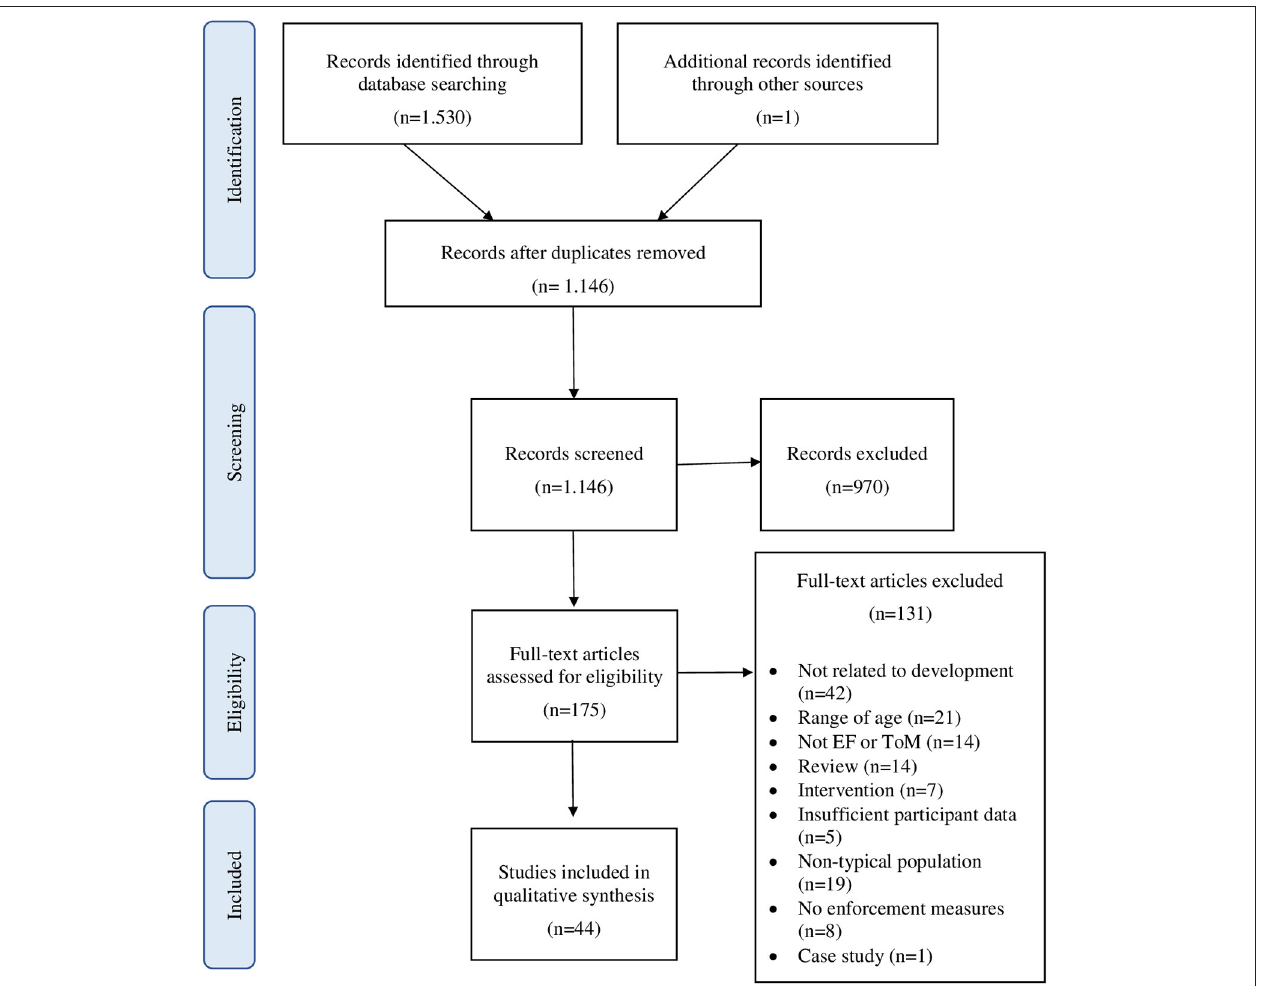
FIGURE 2 | Flow diagram of systematic